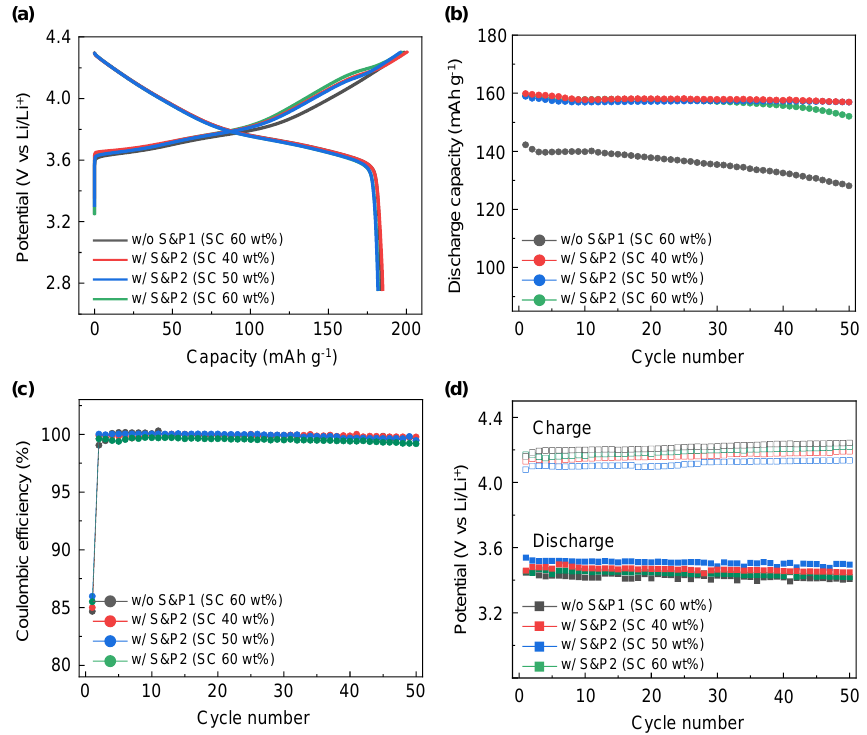
Figure 5. ( a ) Voltage profile of the with S&P2 electrode fabricated with different wt% of solid content (SC) for the formation (initial charge − discharge) voltage profiles at 0.1C rate between 2.75 and 4.3 V at 30 °C. The result of without S&P1 (SC 60 wt%) and with S&P2 (SC 60 wt%) are obtained from Figure 3. ( b ) the following 50-cycle performance at 5C at 30 ◦ C. ( c ) Coulombic efficiency with charge and discharge C-rates of 5C. ( d ) Average voltage changes over the 50 cycle